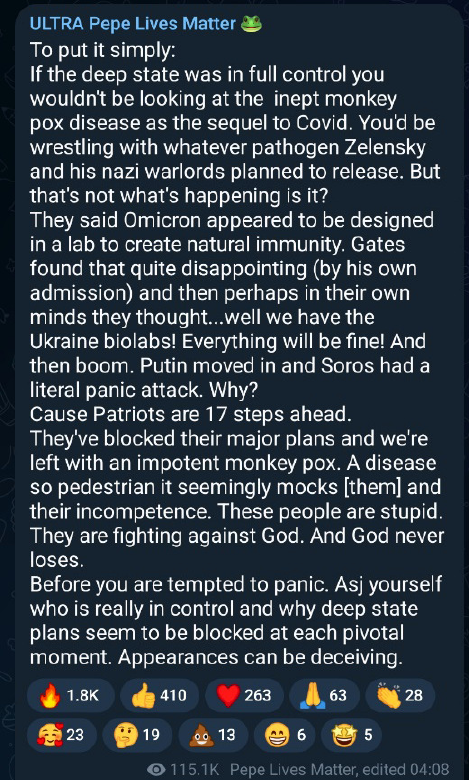
Figure 3. ULTRA Pepe Lives Matter: Put it